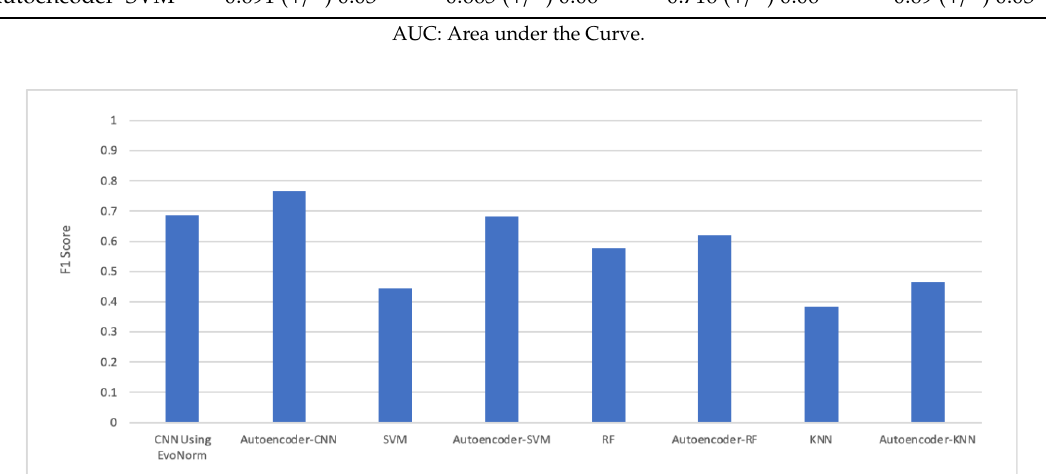
Figure 18. The F1 score.